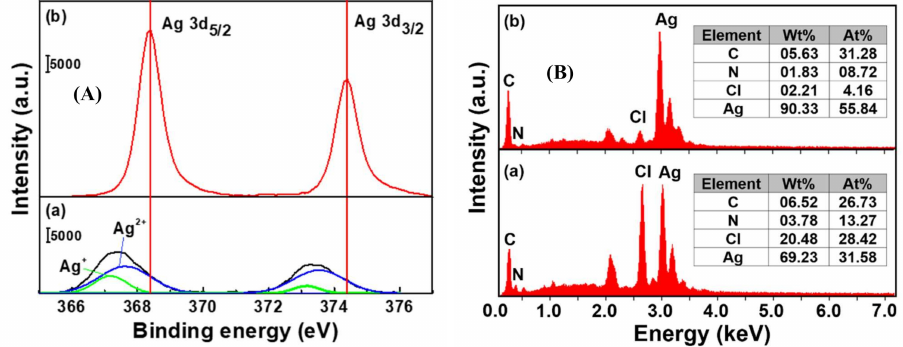
Figure 3. ( A ) XPS and ( B ) EDS spectra of the ( a ) AgCl / PEI / GCE and ( b ) AgNPs / PEI-decorated GCE.